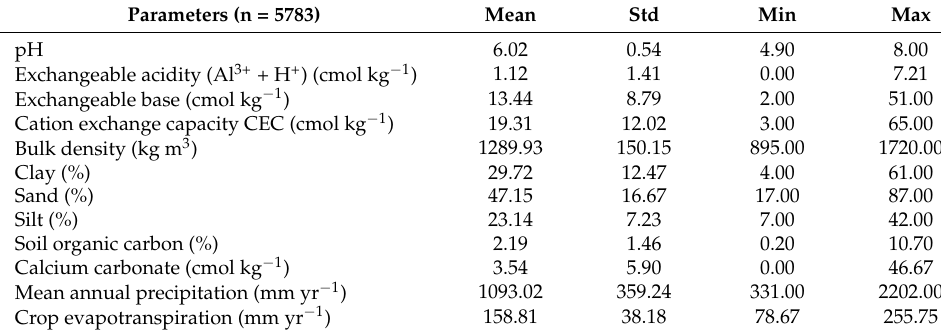
Table 1. Soil properties and crop water